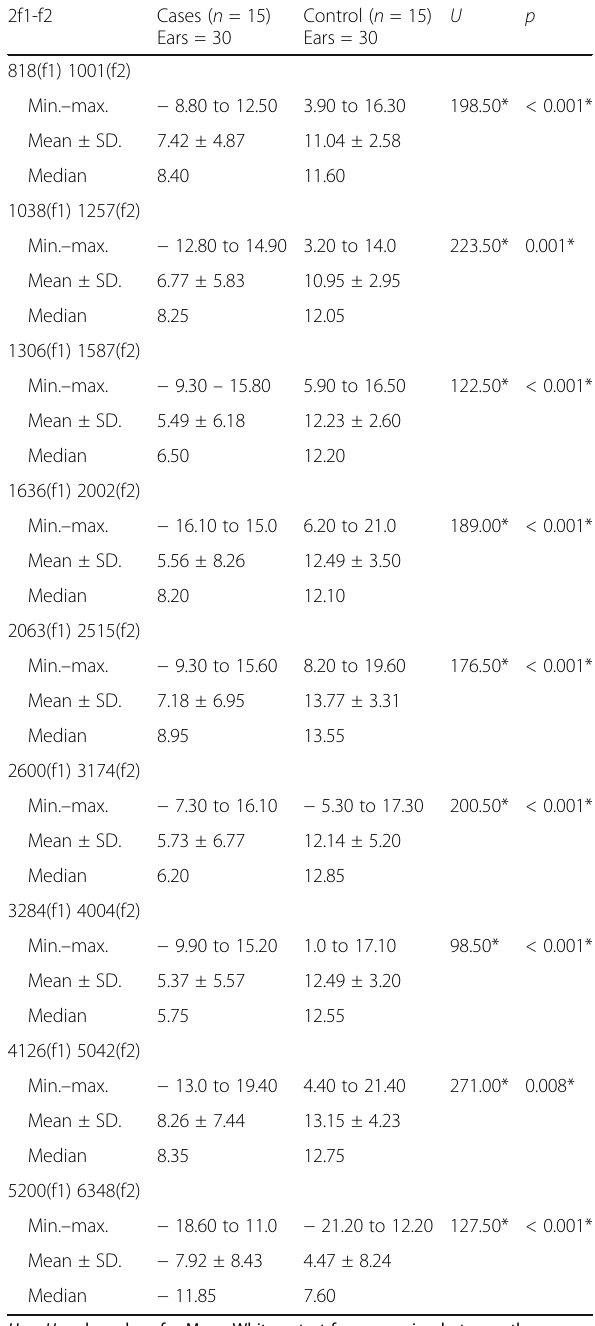
Table 1 DPOAE amplitudes in dB SPL according to 2f1-f2 in tinnitus patients and control